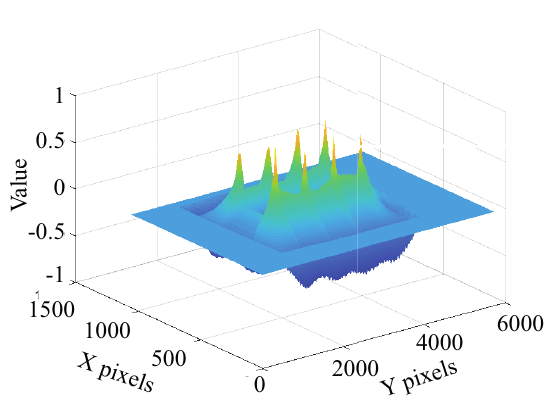
Figure 8. 2D cross-correlation between image and external